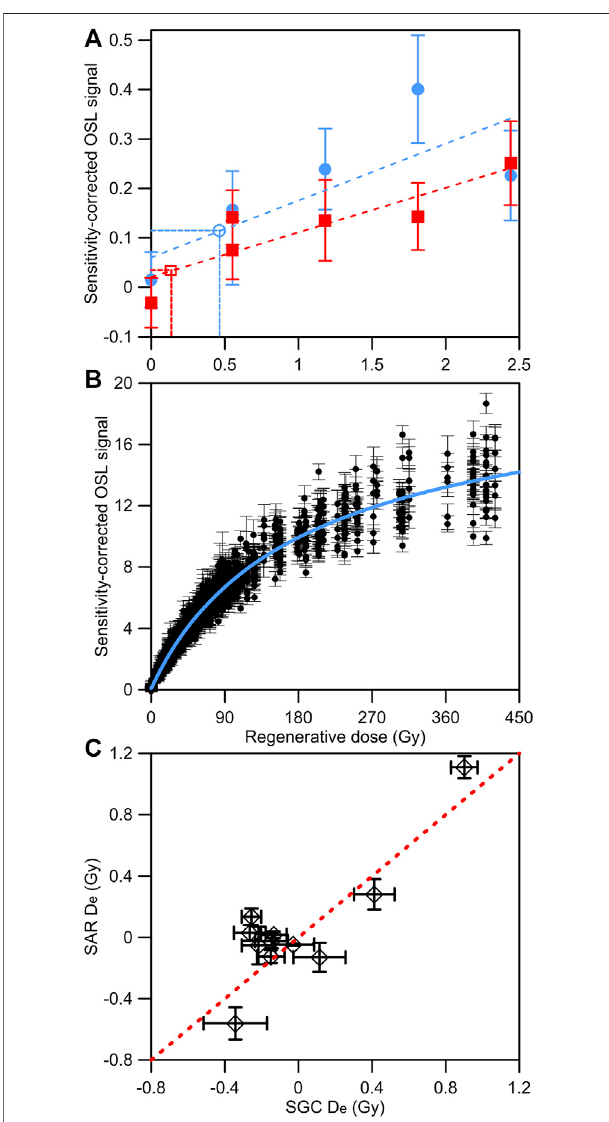
FIGURE3|(A) showsSAR D e determination fortwodifferentaliquotsof sample TDN15-1. The dashed lines indicate the fi tted DRCs. (B) shows the sensitivity-corrected regenerative post-IR OSL signals used for establishing the SGC. The blue line indicates the established SGC. (C) compares SAR and SGC D e estimates for eleven samples. For each sample, the SAR D e estimate were based on twelve aliquots and the SGC ones were based on at least twenty-three aliquots. The dashed red line indicates y =